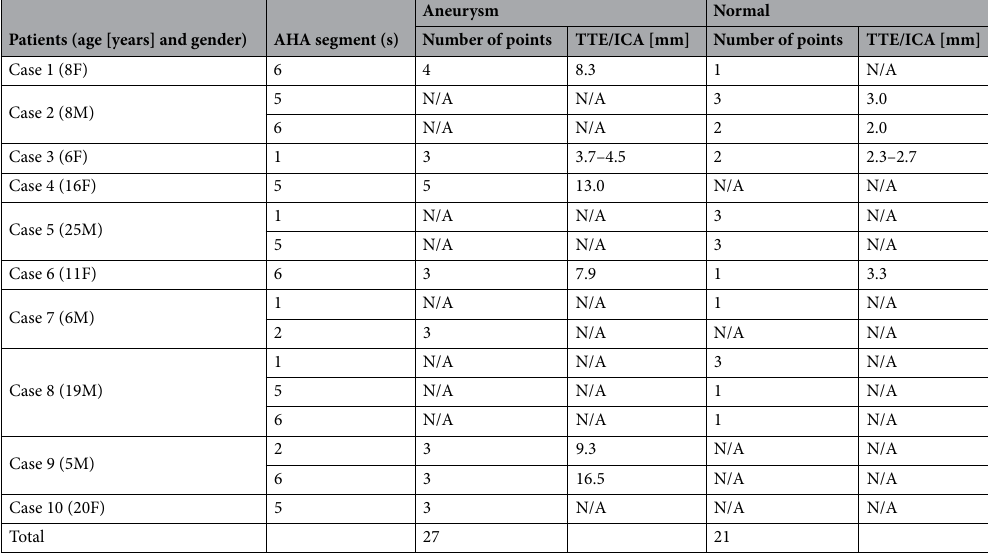
Table 1. The number of points evaluated in 10 patients with Kawasaki disease. AHA American Heart Association, TTE transthoracic echocardiography, ICA invasive coronary angiography, N/A not applicable.